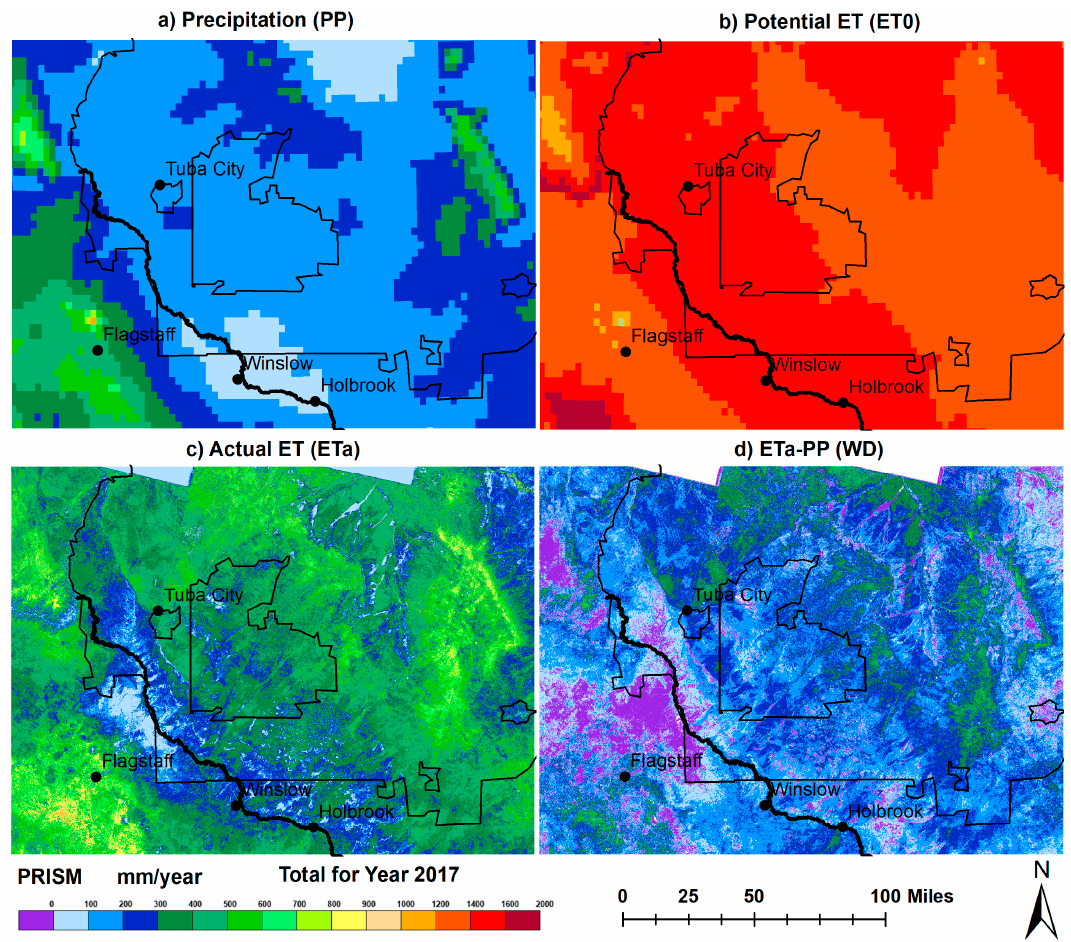
Figure 8 . Annual water metrics [( a ) precipitation (PP), ( b ) potential ET (ETo), ( c ) actual ET (ETa) and ( d ) net water requirement or ETa ‐ PP (WD)] for 2017 using weather data from PRISM (gridded 4 km) and produced at Landsat 30 m resolution for northeast Arizona.